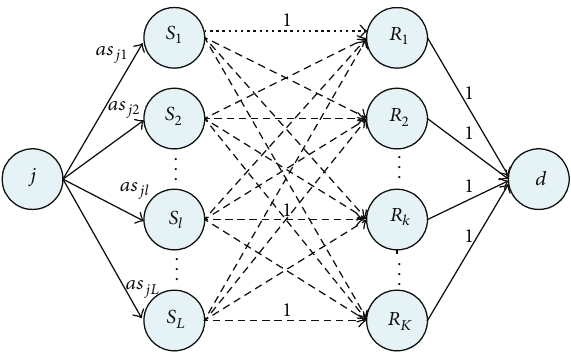
Figure 1: Maximum flow model for flexible resource